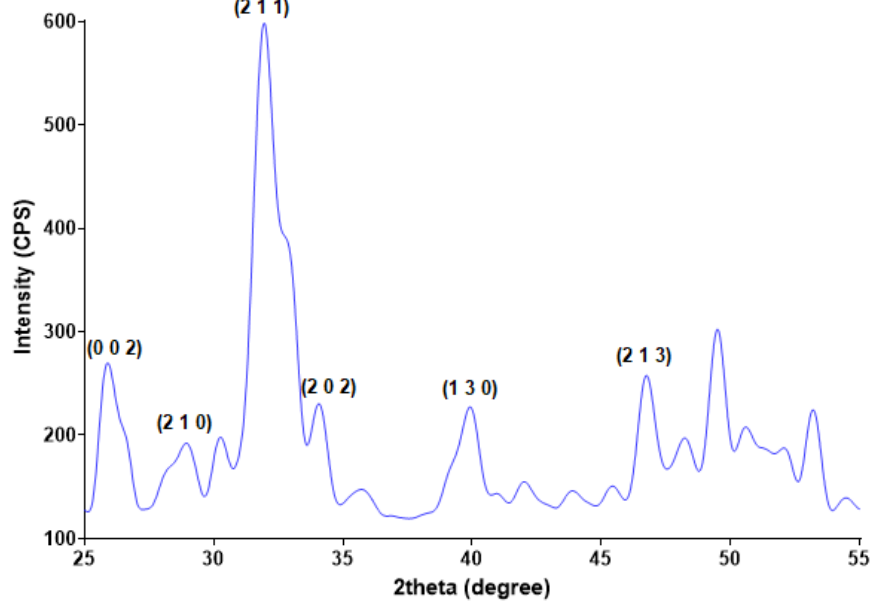
Figure 1. XRD pattern of HAp powder.